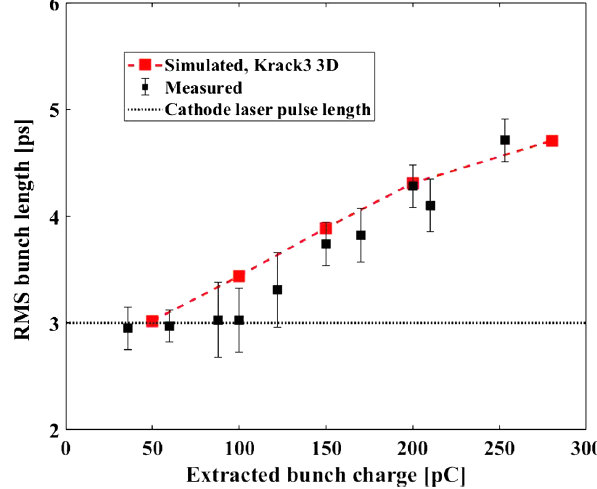
FIG. 16. Comparisons of the bunch length at the injector exit between measurement and simulation for different bunch charges. Note that the extracted bunch charge is varied by changing the laser pulse energy on the cathode while keeping all rf settings unchanged. The transmission of the laser pulse energy is controlled by a polarizer attenuator. The charge is then measured by means of a toroid right after the rf